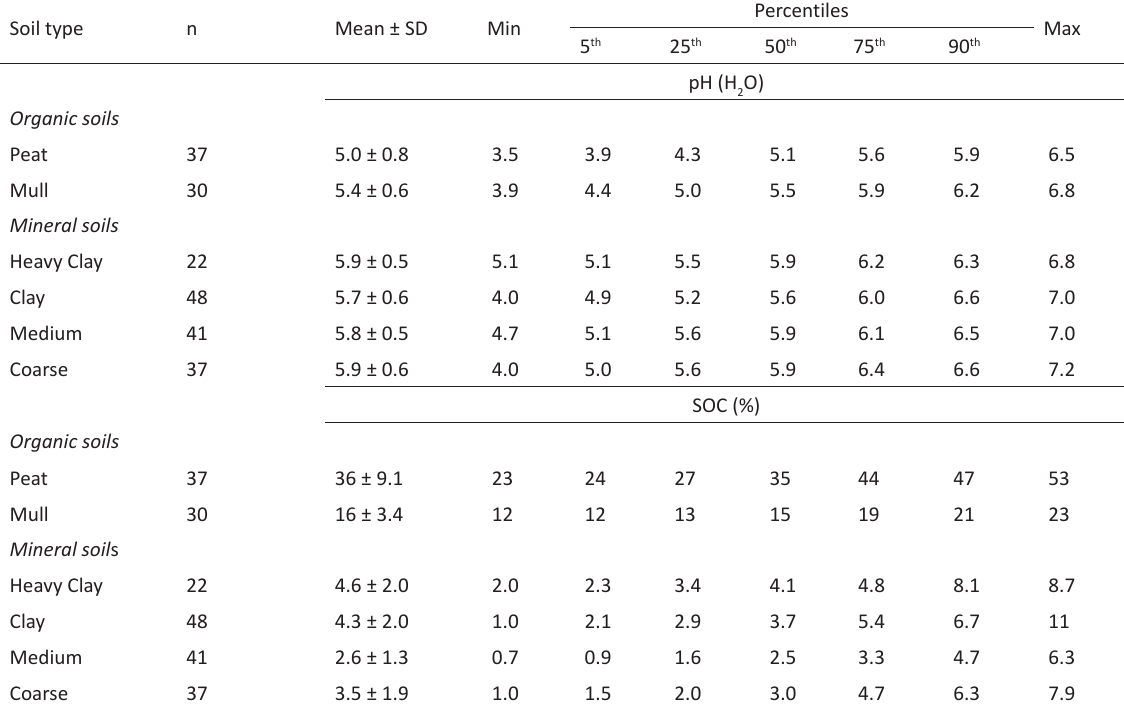
to mull soils (16%, range 12−23%) (Table 3). Within mineral soils, the SOC content ranged between 0.7% and 11%, and there was strong overlapping between the different textural groups. However, the mean SOC was higher for Table 3. General statistics for soil organic carbon (SOC) and pH measured in water in different soil types Soil type